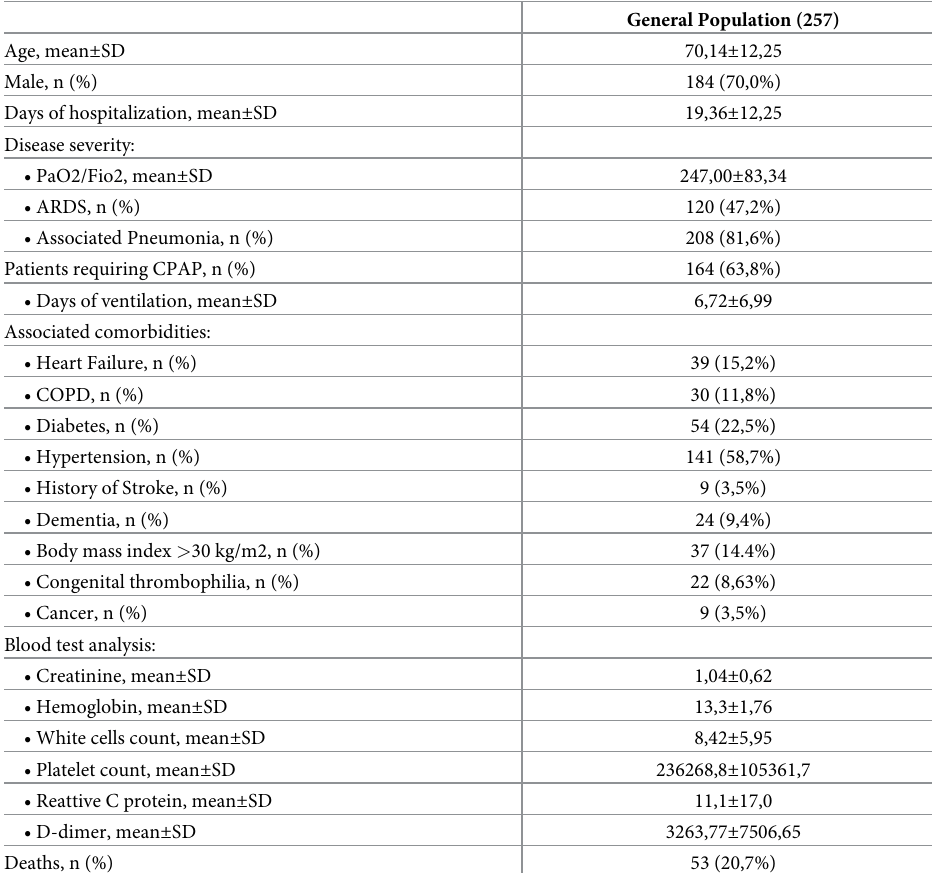
Comparisons between patients with UEDVT and those without are reported in Table 3; 18 UEDVT patients (64.3%) were symptomatic for edema or pain of the upper extremities. Of all UEDVT, 8 (28.6%) were catheter-related and 9 (32.0%) were bilateral. The subclavian vein was involved in 3 patients (10.7%) with one patient showing bilateral thrombosis and another one catheter-related thrombosis. The axillary vein was involved in 25 patients (89.3%) with 9 (32.1%) patients showing bilateral thrombosis and 7 (15.9%) catheter-related thrombosis. No brachial or jugular thrombosis was reported. Patients with UEDVT did not differ from those without UEDVT in terms of age, sex, BMI or comorbidities. Patients with UEDVT were more likely to have a positive history of thrombophilia than patients without UEDVT (28.6% vs 6.17%; p < 0.01). UEDVT was more frequent in patients affected by more severe COVID19 as they showed sig- nificantly lower PaO2/FiO2 ratio (212.77 ± 86.92 vs 251.35 ± 82.06; p < 0.05), increased incidence of associated pneumonia (96.4% vs 79.7%; p < 0.05) and in a higher percentage met diagnostic crite- ria for ARDS (75.0% vs 43.8%; p < 0.001). D-dimer levels at admission were higher in patients with UEDVT (8387.0 ± 12049.26 vs 2614.0 ± 6478.41; p < 0.0001) with increased prevalence of sub- jects with levels above the reference range than non-UEDVT patients (89.3% vs 42.4%; p < 0.001). Patients with UEDVT more frequently required CPAP ventilation (92.9% vs 60.3%; p < 0.0001), however there was no difference in the duration of ventilation between the two groups (days, 12.31 ± 6.30 vs 10.18 ± 5.93; p = n.s.).